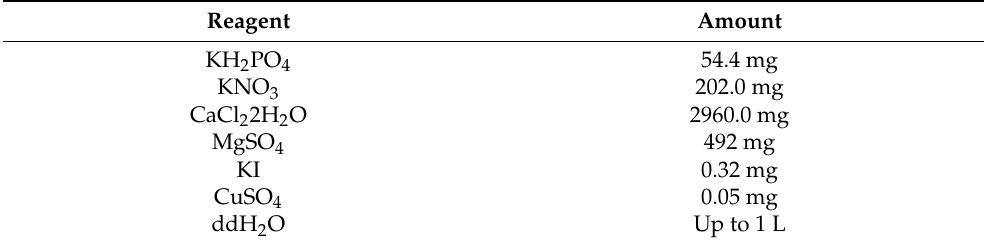
Table 1. Composition of the 2 × CPW solution (1